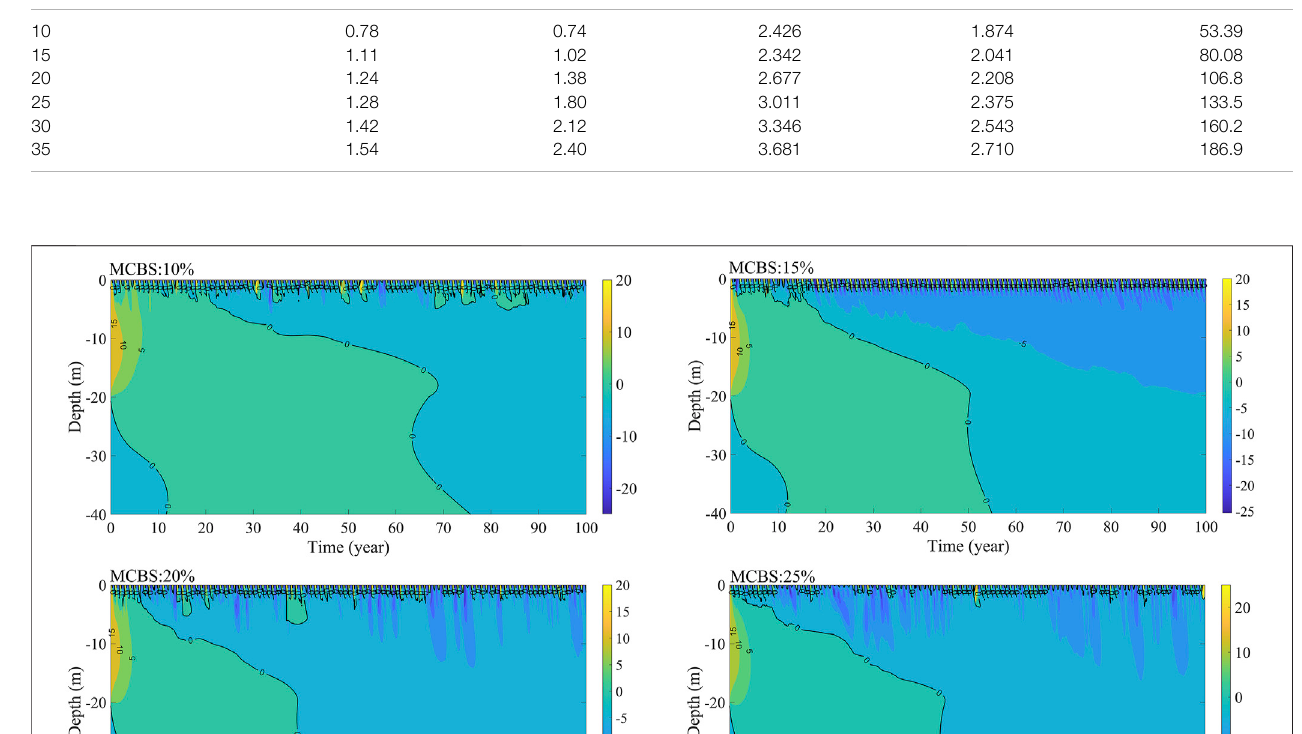
Frontiers in Earth Science |